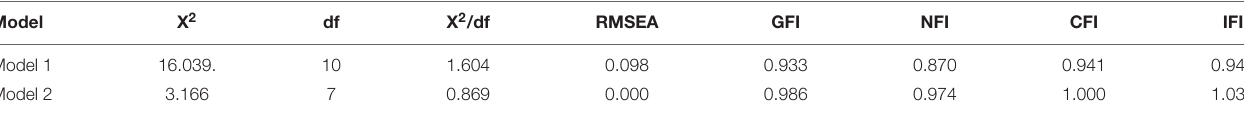
TABLE 7 | Fit indexes of hypothetical models of path analysis based on social support network and perceived social